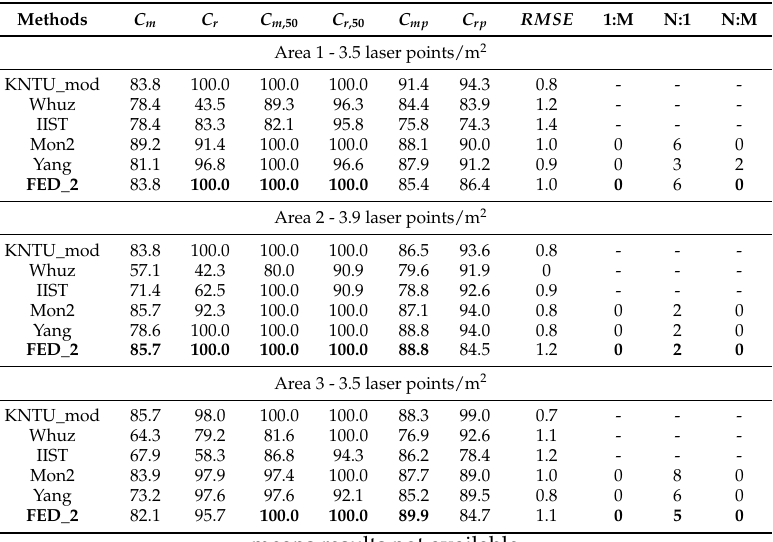
Table 7. Comparing building detection results for the Vaihingen (VH) data set. Object-based C m = completeness, C r = correctness ( C m ,50 and C r ,50 are for buildings over 50 m 2 ) and pixel-based C mp = completeness and C rp = correctness are in percentage. RMSE = planimetric accuracy in metres. 1:M = over-segmentation and N:1 = under-segmentation, N:M = both over- and under-segmentation in the number of buildings. Bold values show better or equal performance of the proposed technique.